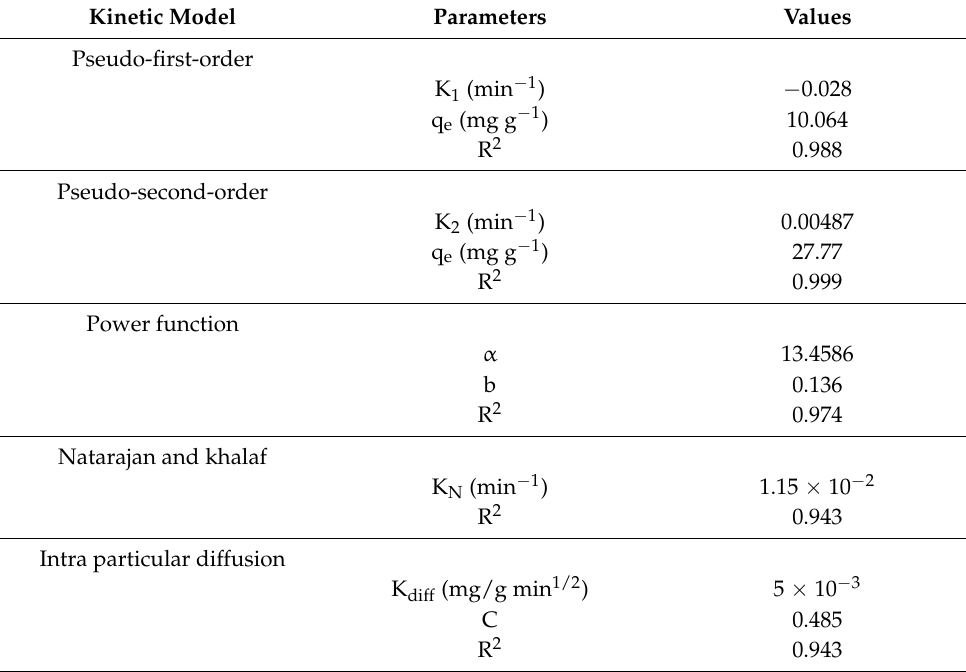
Table 3. Kinetic parameters for Fe(II) biosorption on